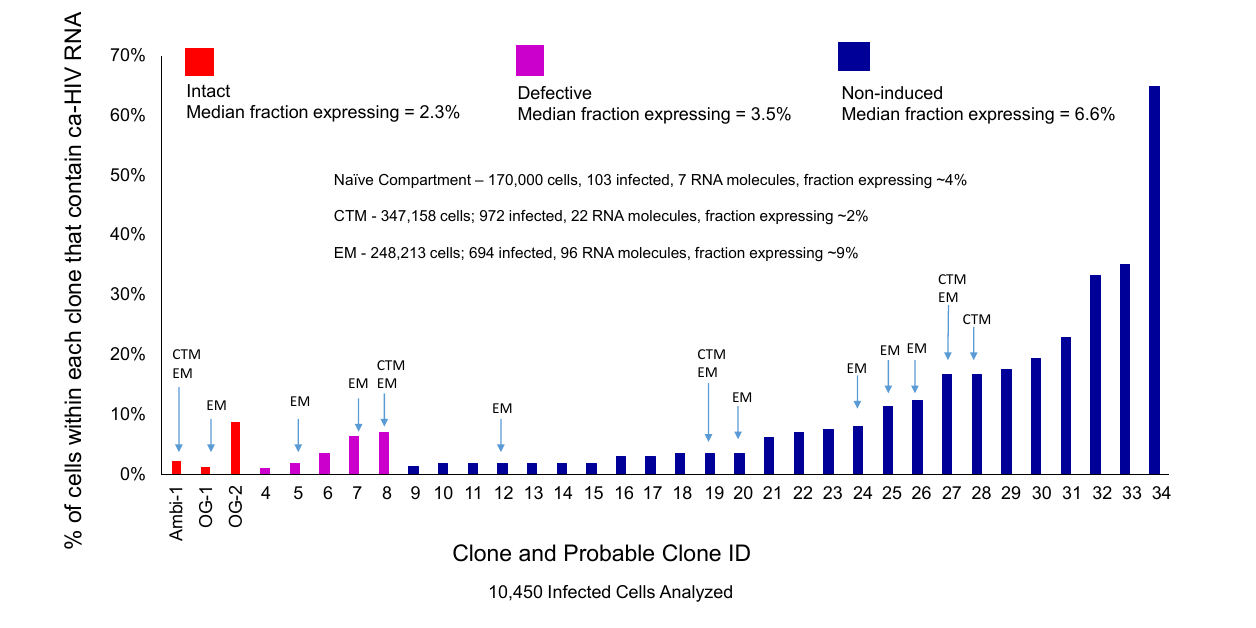
FIGURE 4 | Plot of the fraction of cells that contained ca-HIV RNA for each of the 34 different clones/possible clones. Replication-competent clones/possible clones (shown in red) are intact and outgrowth was observed in VOA. Defective clones (shown in purple) were hypermutated and contained stop codons. Non-induced possible clones (shown in blue) did not contain obvious defects but outgrowth of the matching virus was not observed by VOA. About 50–1200 cells within each clone/possible clone were assayed for ca-HIV RNA.